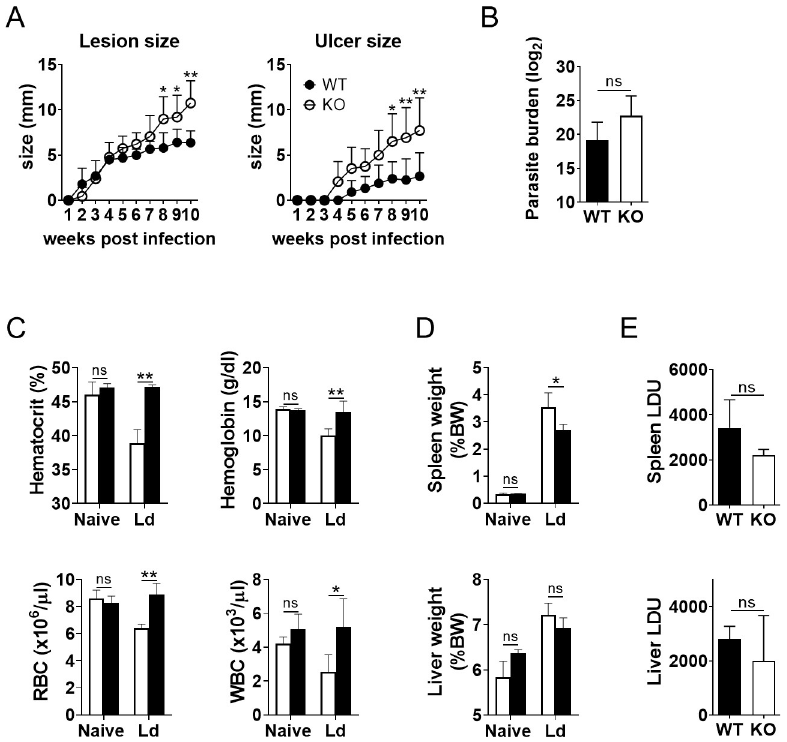
Fig 2. Exacerbated lesion development in L . major infection and alleviated anemia and splenomegaly in L . donovani infection by MRP14 depletion. (A) The size of the skin lesion and ulcer of the ear in L . major -infected WT (n = 5) and MRP14KO mice (n = 5) was measured every week. (B) Parasite burdens of auricular lymph nodes in L . major -infected WT and MRP14KO mice were measured by limiting dilutions. These are a representative of two independent experiments with similar results. (C, D) Hematological data (C) and organ weights (D) of L . donovani - infected WT (n = 4) and MRP14KO mice (n = 5) at 24 weeks of infection are shown. (E) Parasite burdens in the spleen and liver of L . donovani -infected WT and MRP14KO mice at 24 weeks of infection were determined by microscopy of Giemsa-stained smears and are expressed as LDU. These are a representative of three independent experiments with similar results. Means and SD of each group are shown. ns, not significant, � P < 0.05, �� P < 0.01 by Mann-Whitney